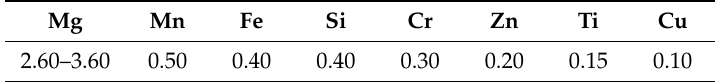
Table 1. Alloying elements and their nominal weight percentage in AA5754 H111.